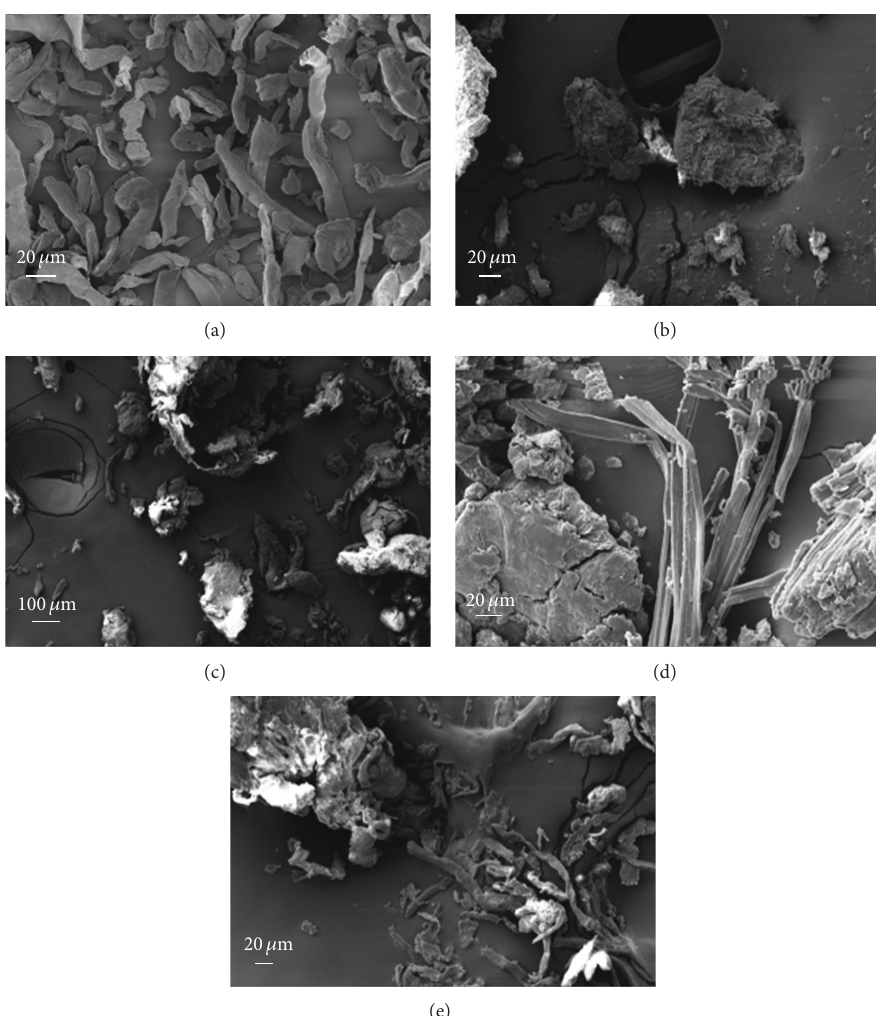
Figure 4: Revealing SEM images of commercial cellulose, cMCC (a), lignocellulose (b), hydrochloric (c), nitric (d), and sulfuric (e) cellulose.